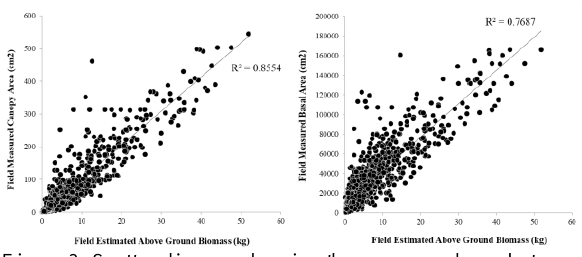
Figure 3. Scatter diagram showing the correspondence between measured canopy areas, basal area and estimated above-ground biomass using allometric equation (Buras et al., (2012) for 1383 shrubs in 32 plots.